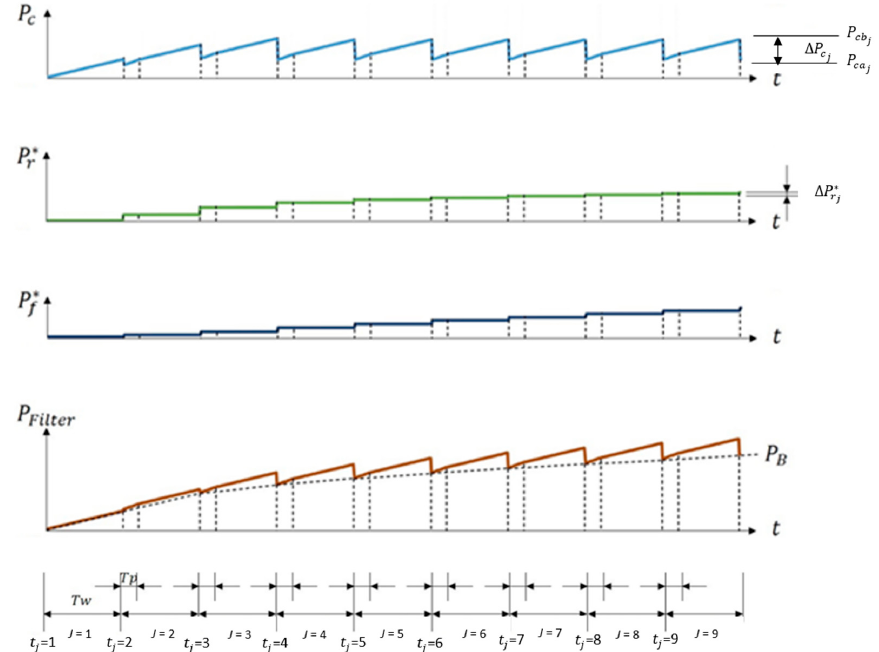
Figure 3. The model of filter elements in pulse dust collector. (1) Filtration